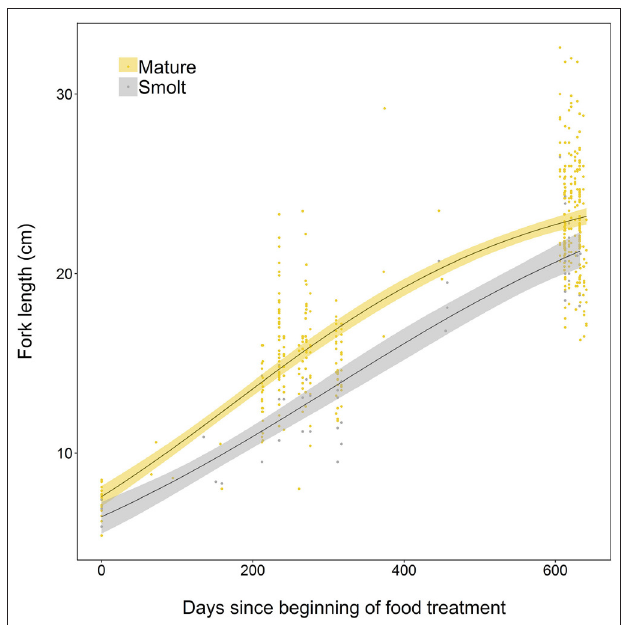
FIGURE 6 | Growth curves, based on length measurements spanning 2 years of experimental tank rearing, of brown trout derived from two population backgrounds (anadromous or non-anadromous). Fitted lines are based on the best-fitting parameters from the logistic growth model, fitted using non-linear least squares regression. Shaded areas represent the 95% confidence intervals constructed by bootstrapping for 10,000